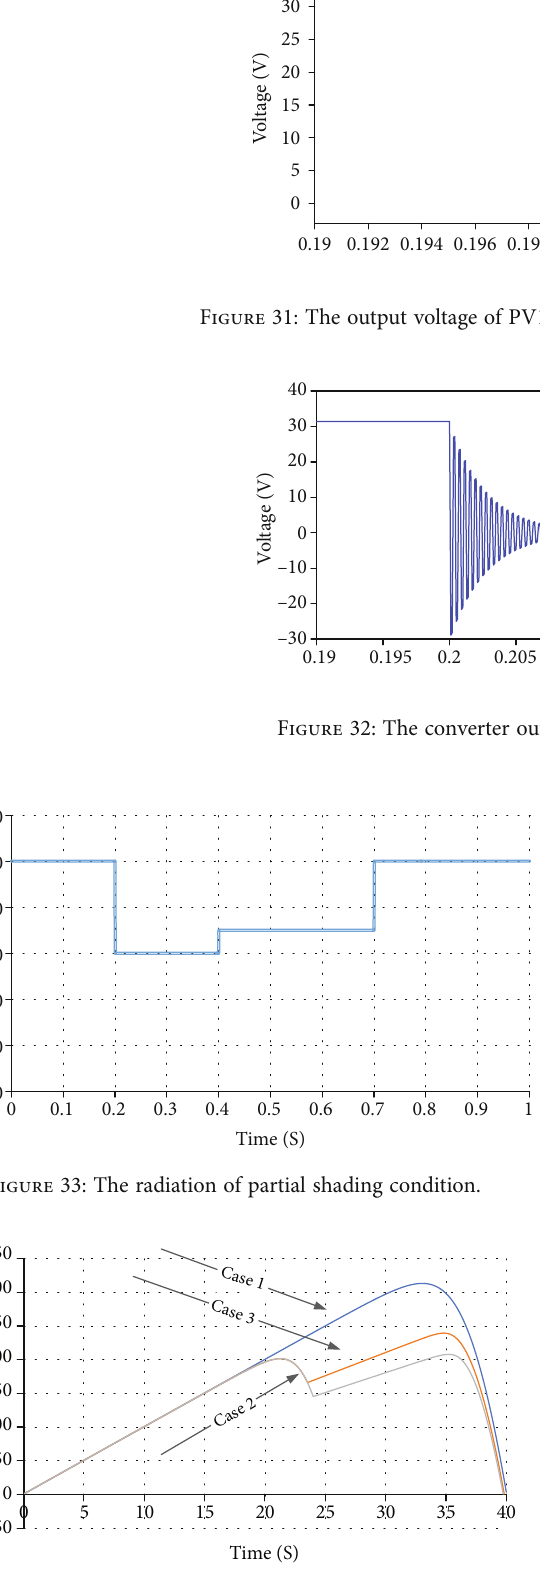
Figure 34: The power-voltage characteristics of PV simulator on di ff erent PSCs.